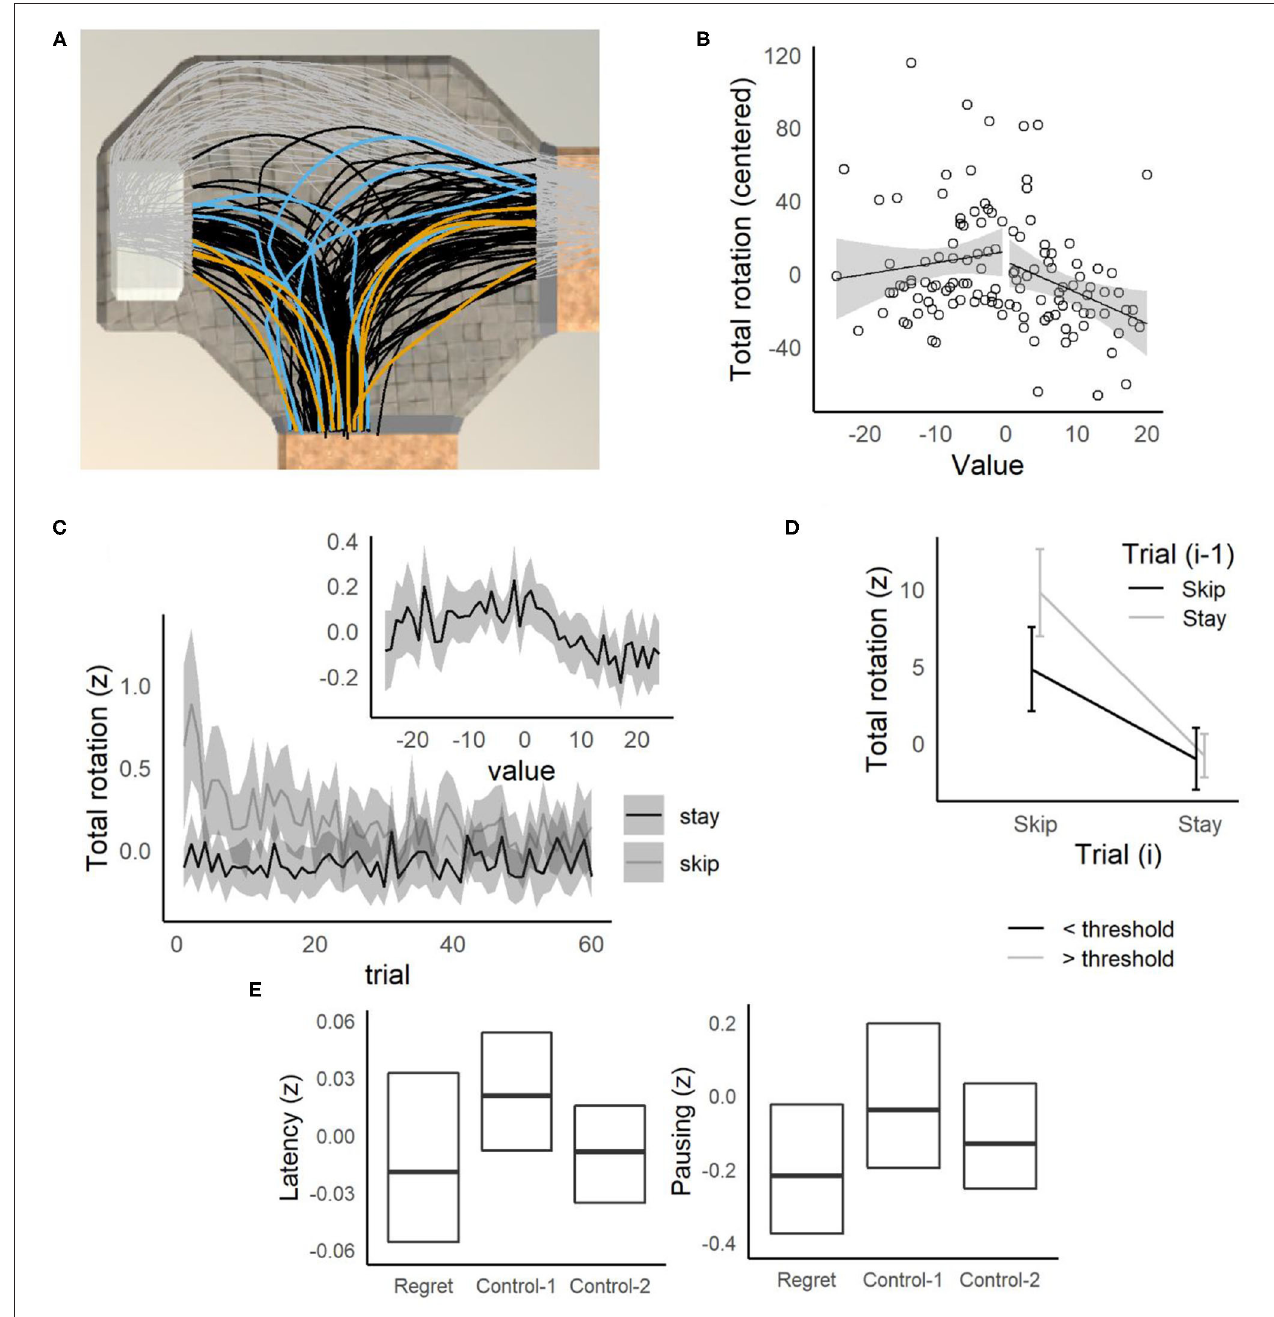
FIGURE 5 | Offer zone behavior. (A) Example of position data from one participant (MRM336), rotated to overlay a single offer zone. All position data are shown as gray points, black lines indicate paths taken up to the point where the participant left the offer zone. Randomly selected trials when the participant’s choice time was slow (blue) vs. fast (orange) show that the participant tended to take longer paths and make corrections on slow trials. (B) Relative to offer value (threshold—offer), total angular rotation was elevated for difficult offers (value = 0) for MRM336. (C) Across participants, total rotation was elevated for difficult decisions (value = 0). Total rotation decreased across trials for skip decisions, but not stay decisions. (D) Total rotation was higher overall for skip trials compared to stay trials, but highest when participants skipped the current offer after accepting the previous offer. (E) Participants made faster decisions on regret trials, and were less likely to pause, compared to control-1